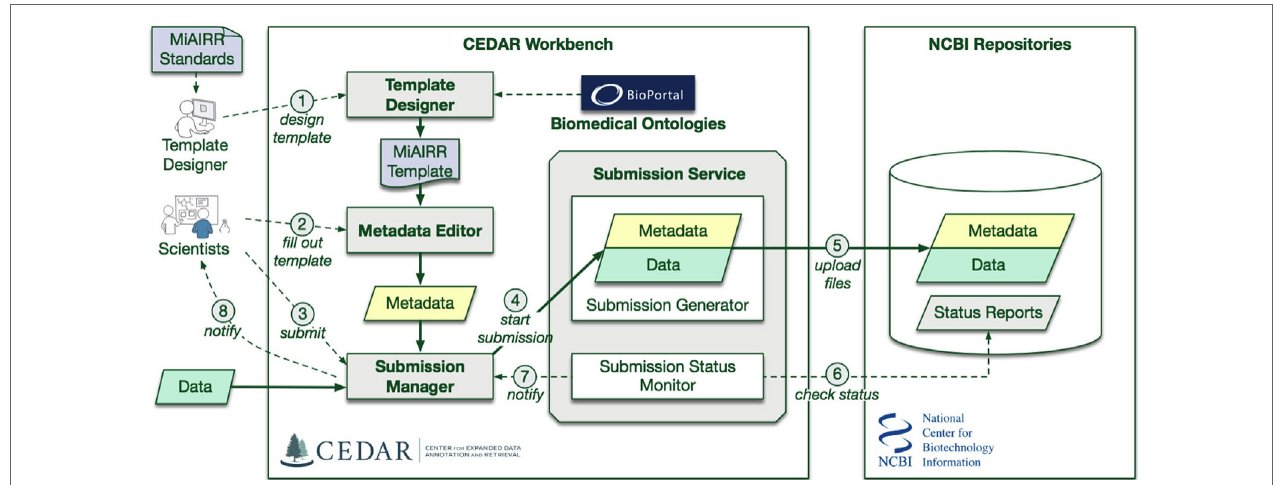
FIgURe 1 | CAIRR Submission Pipeline Workflow. (1) The CEDAR Template Designer is employed to create a set of templates according to the Minimal Information about an Adaptive Immune Receptor Repertoire (MiAIRR) standard. (2) Scientists can log into the CEDAR Workbench and use these templates to edit ontology- controlled metadata associated with their AIRR-sequencing study. The edited metadata is pre-validated through the National Center for Biotechnology Information (NCBI) validation service. (3) Scientists can start the submission process by accessing the Submission Manager within their CEDAR Workbench workspace. (4) The Submission Manager connects the CEDAR Workbench to the NCBI. (5) The Submission Manager facilitates uploading the metadata and data (FASTQ files) to the NCBI. (6) The CAIRR pipeline periodically checks the submission status at the NCBI. (7) Alert messages from NCBI are received by the Submission Manager. (8) These alert messages provide step-by-step processing detail to the